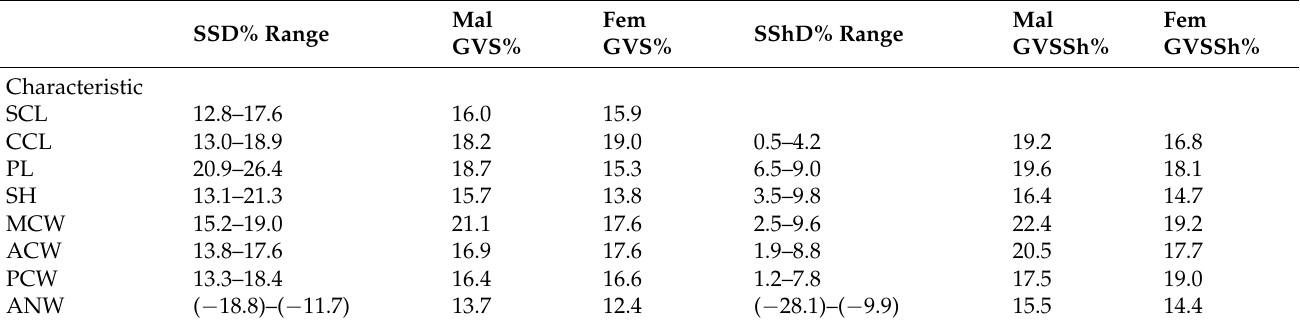
Table A3. Degrees of geographic variation in body size (GVS) and in shell shape (GVSSh) calcu- lated for each sex. Abbreviated characteristics are explained in the Materials and Methods section. Mal—males; Fem—females. Results were calculated for each characteristic as: 100 ((Population of largest specimens − population of smallest specimens)/population of smallest specimens).